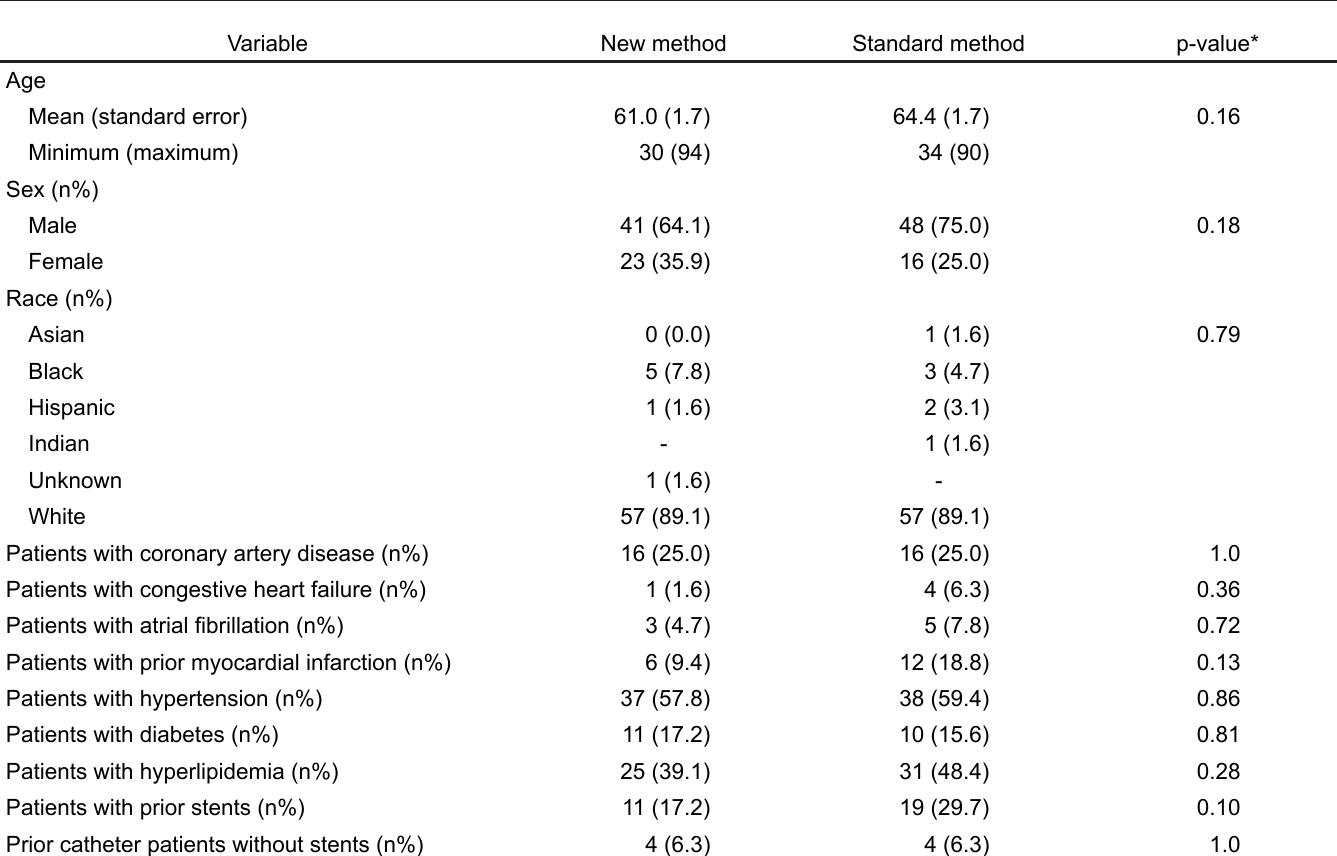
Table 1. Comparison of patient demographics by Notification Method, dispatcher-aided (new) vs. medic to physician (standard method), for ST-elevation myocardial infarction